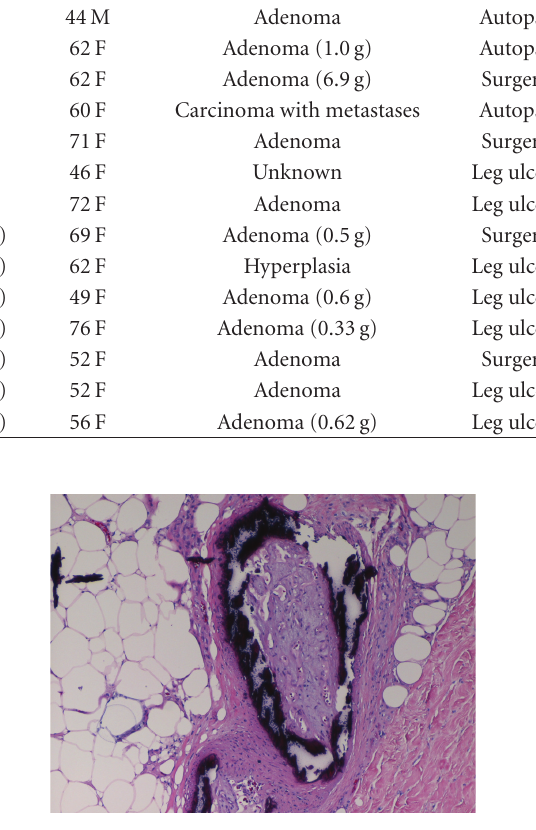
Figure 4: Evidence of primary hyperparathyroidism with hyper- plastic cells within the parathyroid tissue. A paucity of adipose tis- sue is visible in the gland, suggesting the presence of a hyperplastic